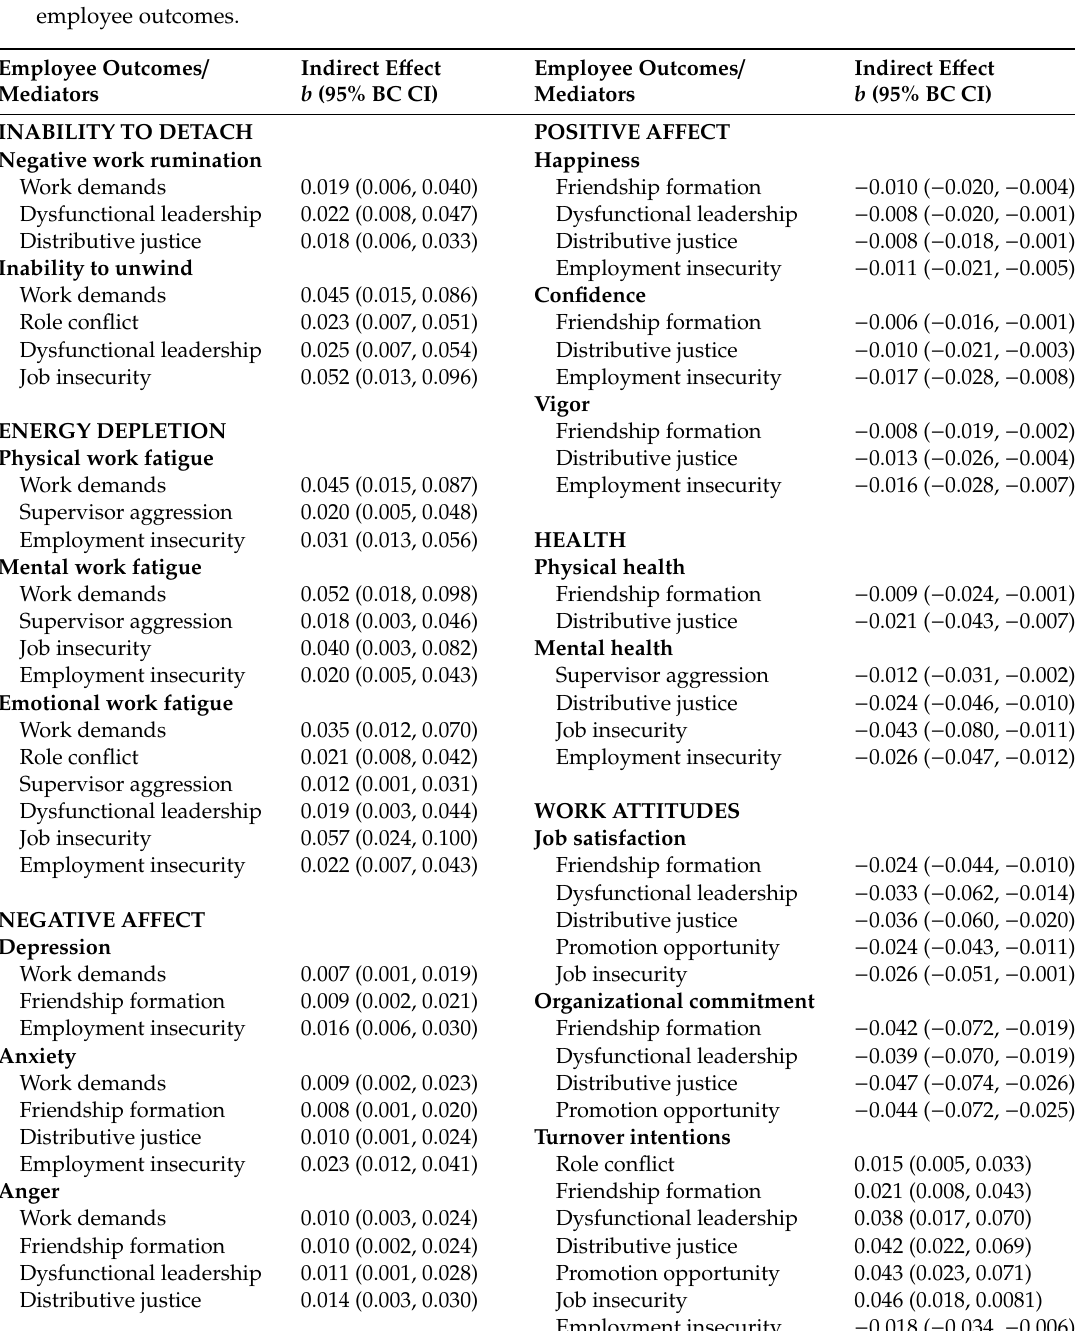
Table 4. Statistically significant mediators of the associations of organizational downsizing to employee